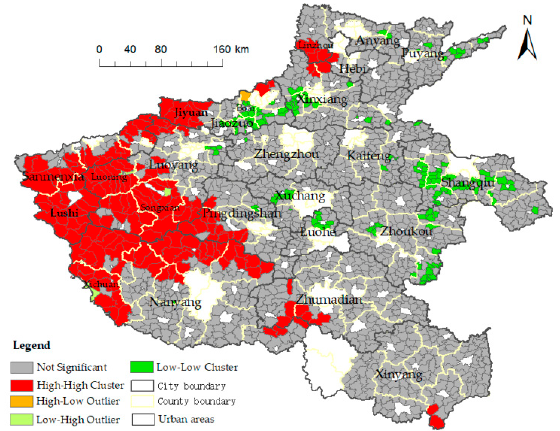
Figure 6. Local indicators of spatial association cluster map of spatial accessibility to medical facilities.